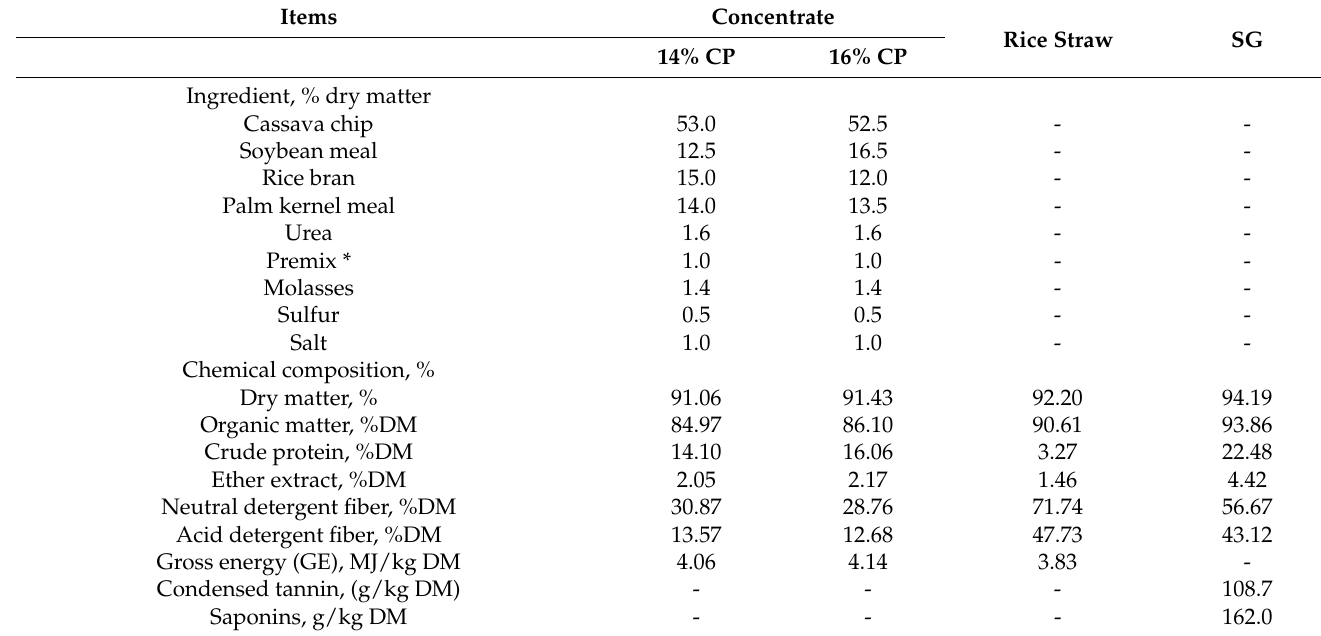
Table 1. Feed ingredients and chemical composition of concentrate diet containing various crude protein (CP), rice straw, and S. grandiflora pods meals (SG). DM, dry matter.